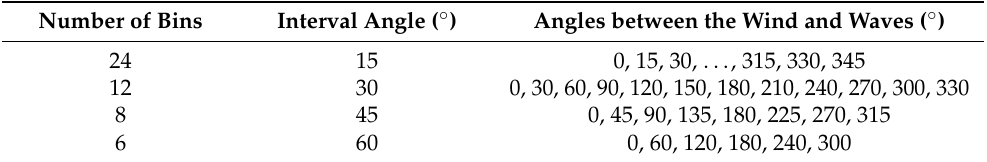
Table 5. Summary of the bins according to the interval angle of wind and waves.